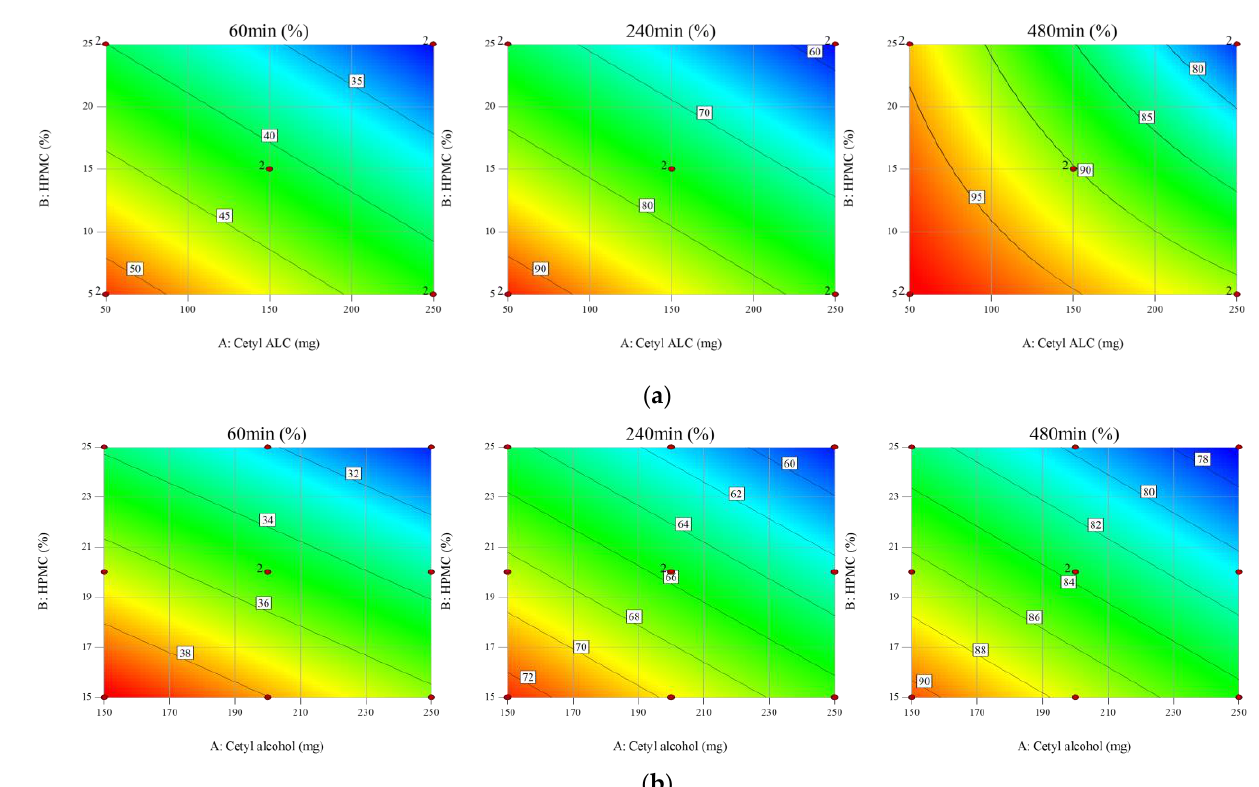
Figure 2. Contour plots of ( a ) the two-level full factorial design (FFD) and ( b ) the response surface method (RSM).